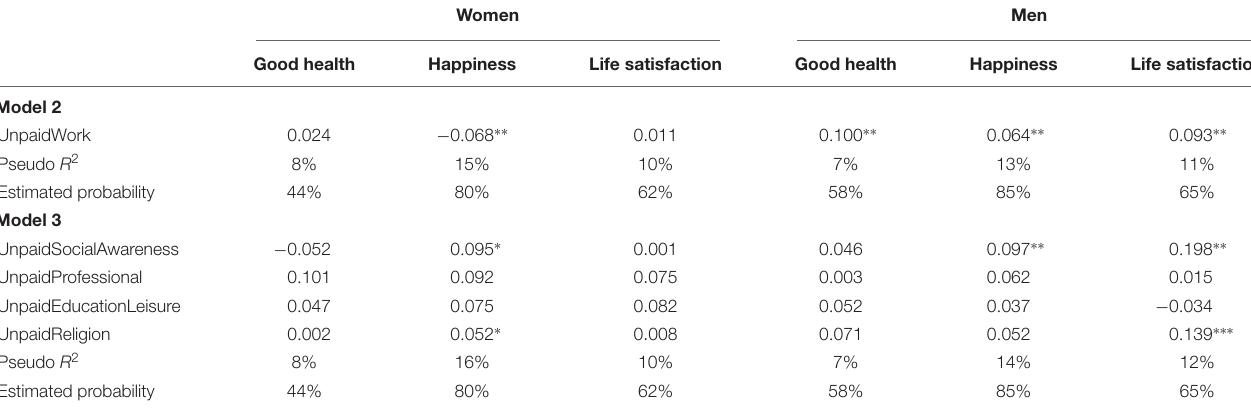
TABLE 5 | Estimations of wellbeing indicators: Model 2 and Model 3 by gender (Logit: